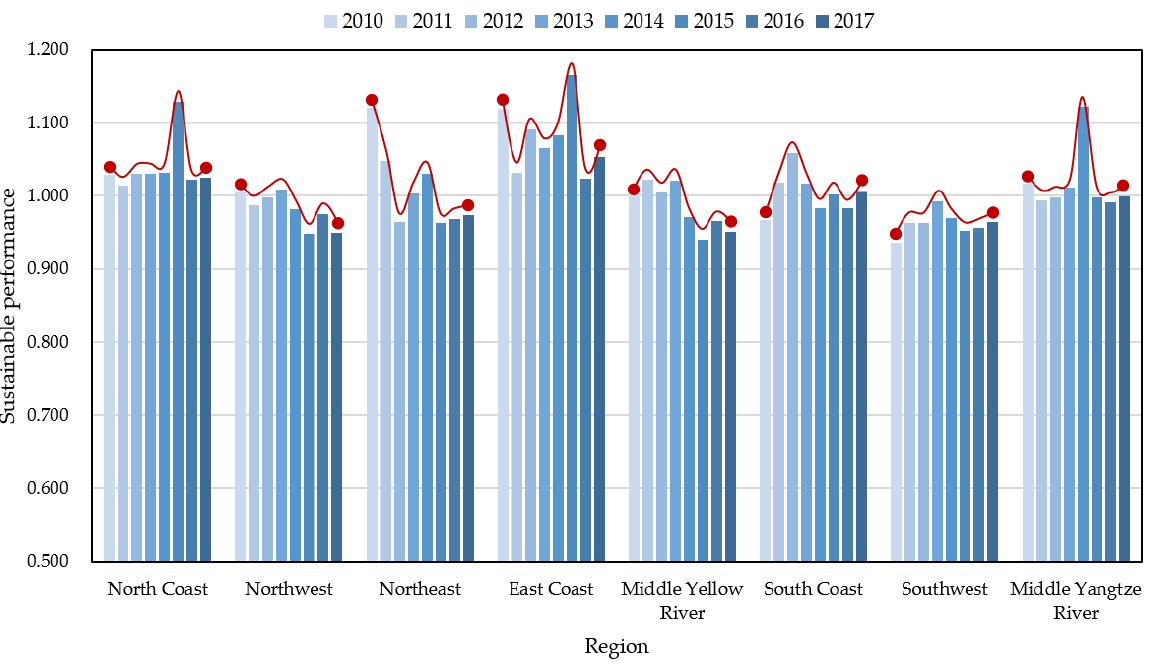
Figure 3. The scores for the SPCI in the eight regions from 2010 to 2017. Figure 4 depicts the spatial evolution of the scores for the SPCI. Two stages can be observed. (1) From 2010 to 2014, there was no significant change in the CV . Meanwhile, the spatial autocorrelation was erratic and insignificant. (2) From 2015 to 2017, the CV followed a decreasing trend, which indicates that regional inequality is weakened. More- over, all values for the GMI were positive and passed the 0.05 significance test for 2015 and 2017, meaning that the provinces surrounded by provinces with better/poorer SPCI tend to experience better/poorer SPCI. The peak of CV in 2015 indicates that the unbalanced development of SPCI among provinces has reached its peak. This is mainly because the SPCI of JS and BJ increased significantly in 2015, resulting in a sharp increase in the gap between the rich and the poor. The substantial increase in SPCI of JS and BJ is mainly due to the significant decline in the number of fatalities in